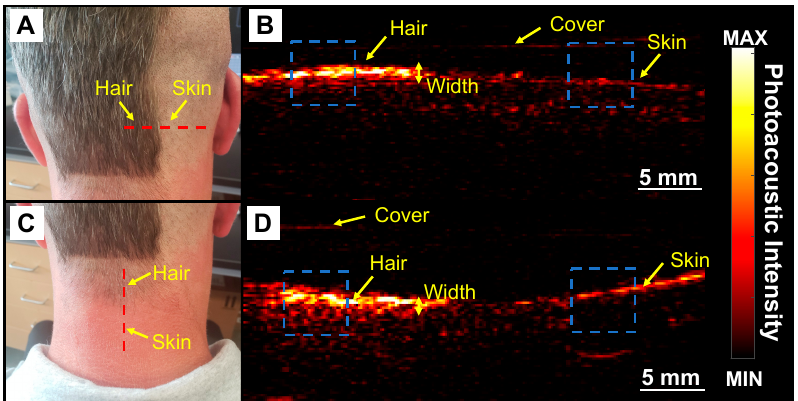
Figure 2. Hair imaging using PAI. This experiment contains positive and negative controls to validate the imaging technique using 690 nm light source. ( A ) Photograph of unshaved and shaved portions of the scalp. Red dashed line represents the imaging plane. ( B ) Photoacoustic image of dashed line in A which includes the skin and full hair. Photoacoustic intensity of hair in full hair area is 4.23-fold higher than shaved skin. ( C ) Photograph of the nape with lower hair density than the scalp. Red dashed line represents the imaging plane in D. ( D ) Photoacoustic image along red dashed line in C. Photoacoustic intensity in this area was 2.8-fold higher than the surrounding skin. Blue dashed squares are the region of interest (ROI) used to measure the PA intensity on the skin and